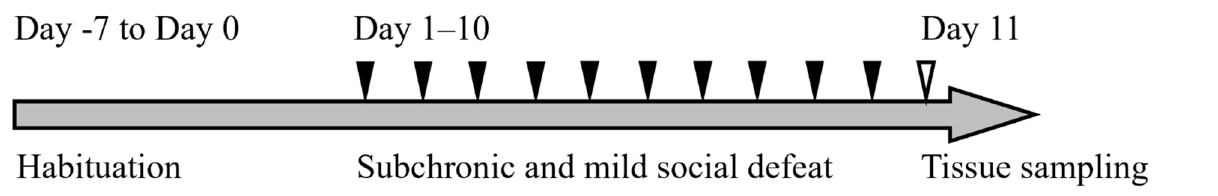
Figure 5. The timeline of this experiment. Mice were habituated in the animal facility (Day − 7 to Day 0) and subjected to sCSDS (days 1–10). Tissue sampling was performed on day